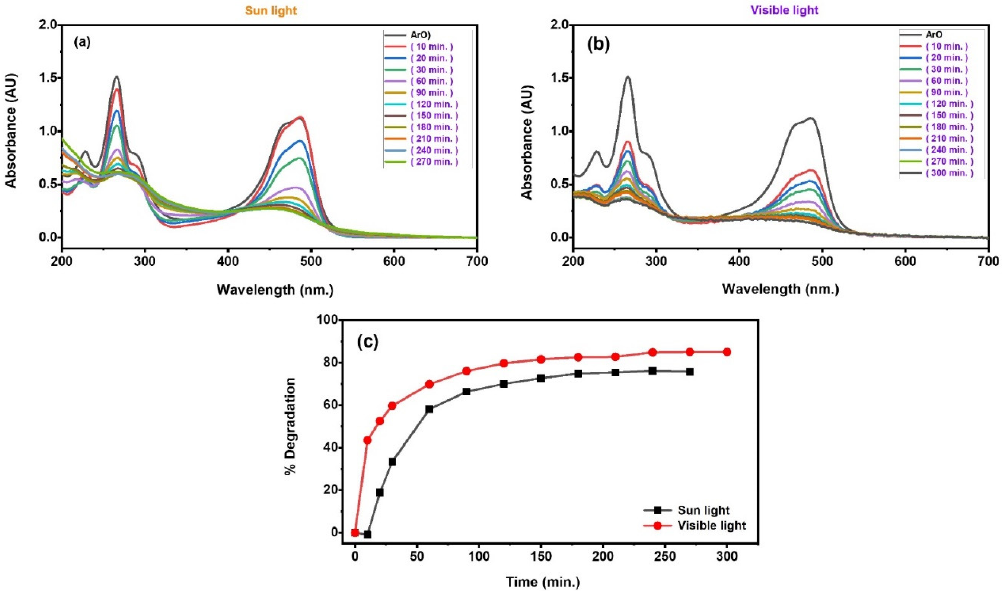
Figure 10. UV–vis absorption spectra for the photodegradation of ArO (0.07 mM) under ( a ) sunlight and ( b ) solar light using Cu@Alg/Co–CeO 2 catalyst (10 beads). ( c ) % Degradation of ArO as a function of time.